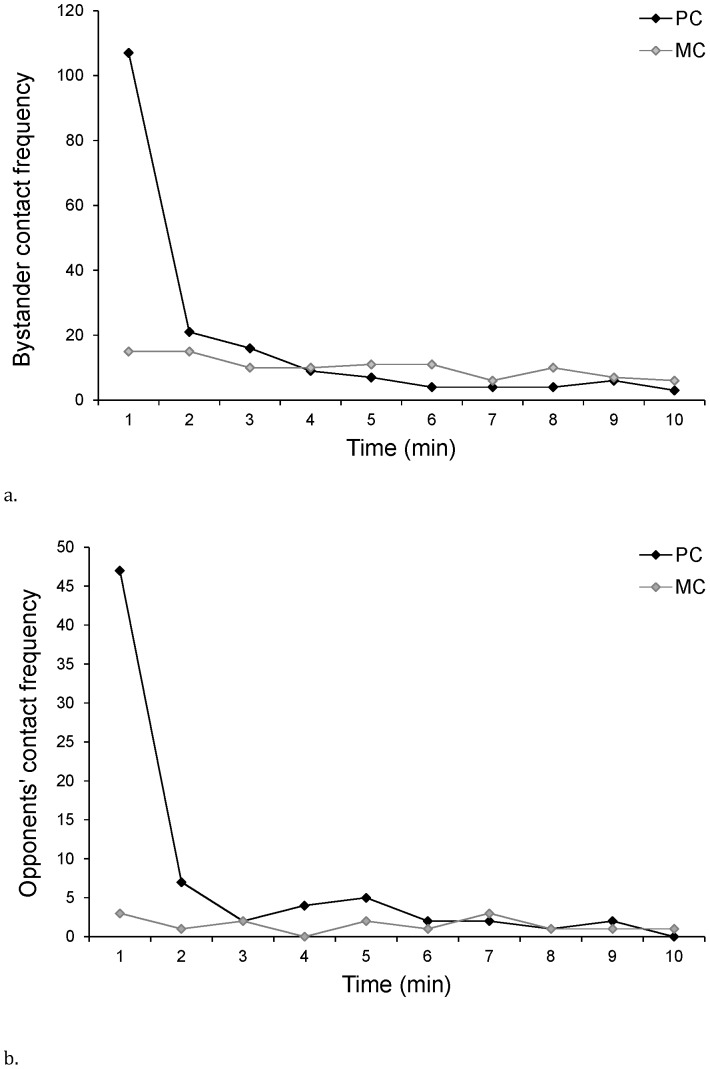
Frequency of first affiliative contacts in conflicts compared to Matched Controls.Frequency over all observations combined of the first affiliative contact offered by (a) bystander to victims of aggression and (b) between opponents in the first ten minutes immediately following conflicts compared to Matched Controls.